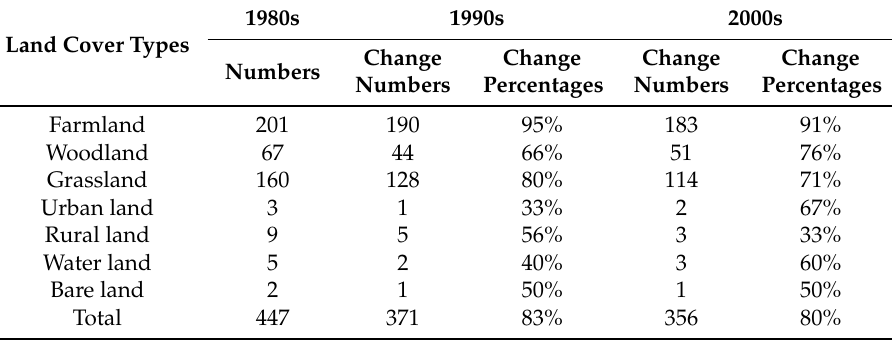
Table 2. The change numbers and percentages of land cover types of Hydrologic Response Units (HRU) between different land cover scenarios.